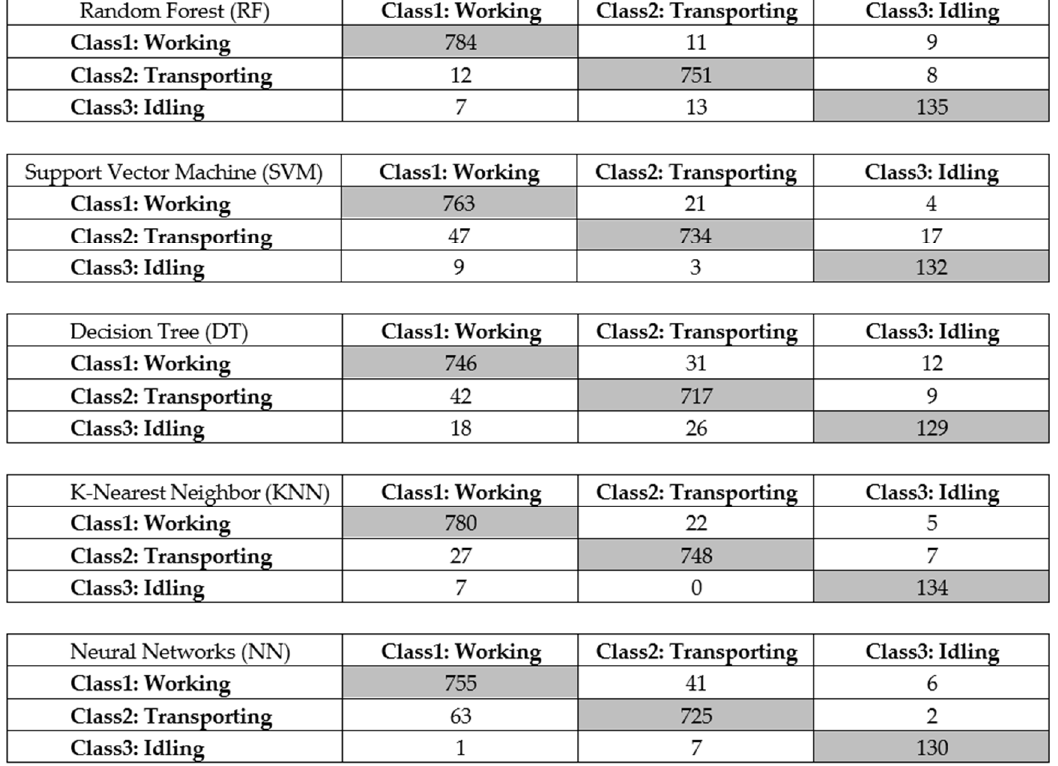
Figure 11. Confusion matrix of the classifiers. The shaded boxes indicate the majority of detection results.